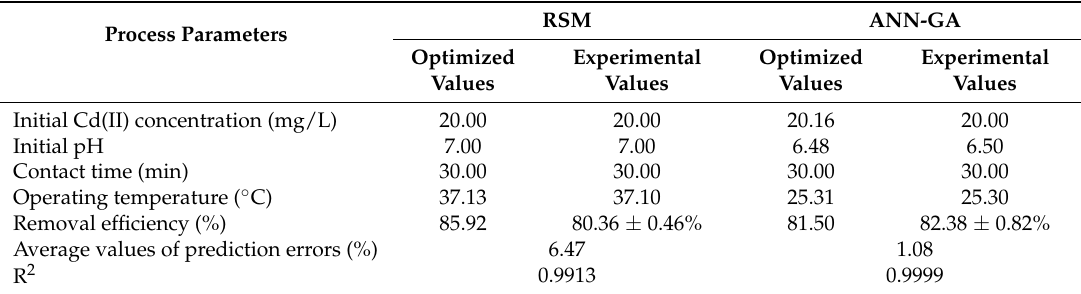
Table 5. Comparative results of confirmatory experiments for model validation.